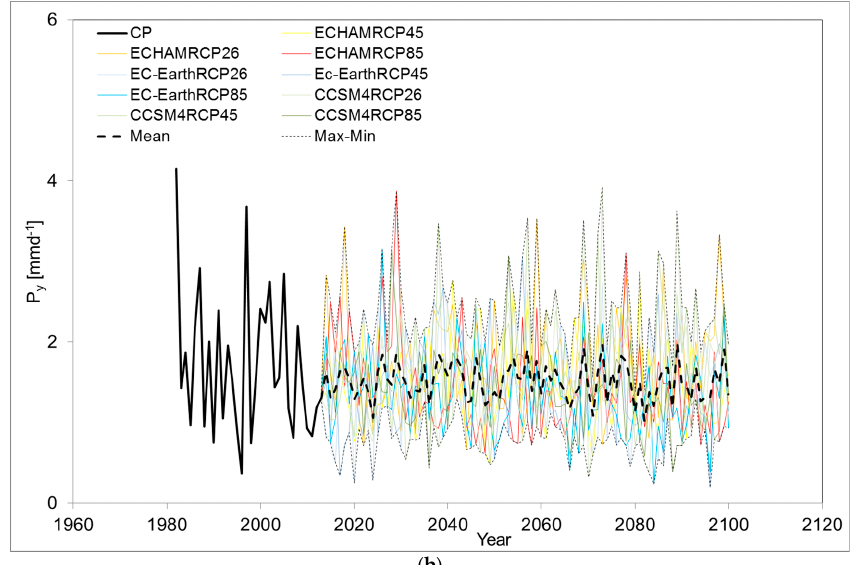
Figure 4. Yearly Climate projections until 2100 vs. CP (1980–2014). ( a ) Temperature at Yeso Embalse. ( b ) Precipitation at San Gabriel.